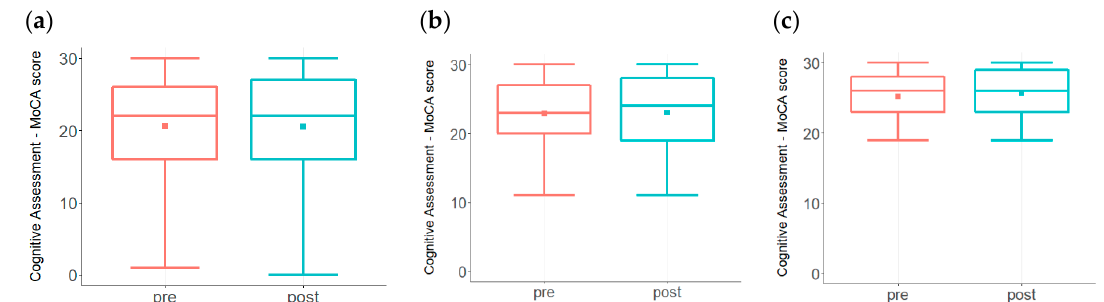
Figure 3. MoCA test scores from participants prior to and after the inception of the program. While there is a trend toward increased scores ( a ) among the entire participant pool ( n = 251), statistical significance was not achieved ( p = 0.484). ( b ). MoCA test scores were evaluated among participants with baseline score ≥ 10 ( n = 212). Improvement in the post-treatment scores was statistically significant ( p < 0.05). ( c ). MoCA test scores of participants ( n = 151) with a baseline score of ≥ 19 showed statistically significant improvement in the post-treatment scores ( p < 0.005).